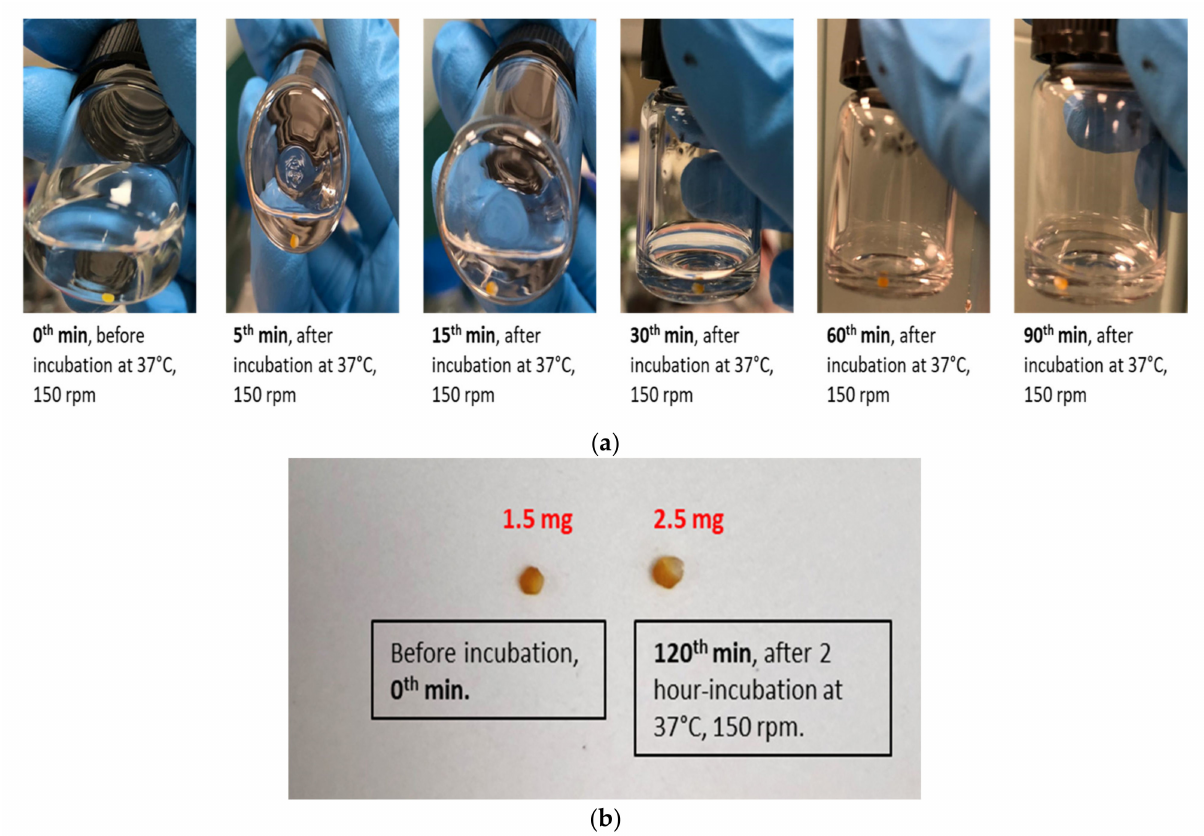
Figure A4. ( a ) Physical observation of CUR-MCT-KC bead at specific time intervals: 0, 5, 15, 30, 60, 90th min under the influence of acidic pH 1.2 over an incubation period of 120 min at 37 ◦ C and 150 rpm, ( b ) The different in weight of CUR-MCT-KC bead before and after the incubation (120 min) at pH 1.2 at 37 ◦ C and 150